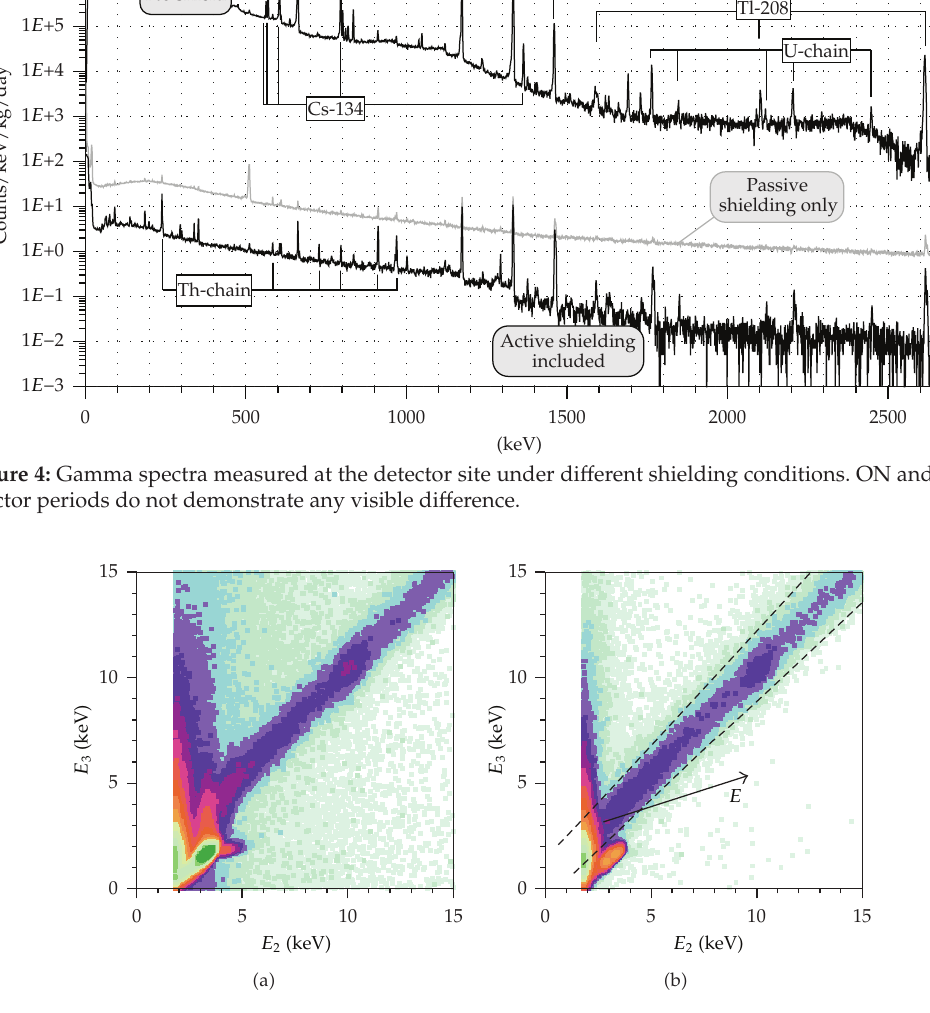
Figure 5: Example of the Fourier analysis made with di ff erent shaping times: ADC-2 operates with 4 μ s pulses, and ADC-3 operates with 12 μ s pulses. Plot (cid:2) a (cid:3) is made before and (cid:2) b (cid:3) after the “audio-frequency” rejection; one can see that most of the rejected events are nondiagonal. (cid:2) The color intensity scale is logarithmic.